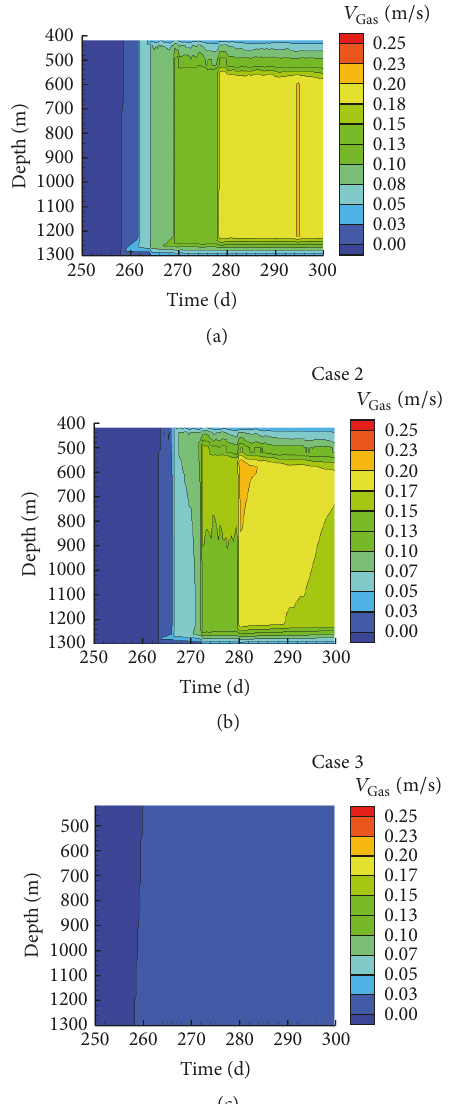
Figure 11: Distributions of gas velocity in the fracture profile for Cases 1 to 3 as gaseous CO 2 evolves.